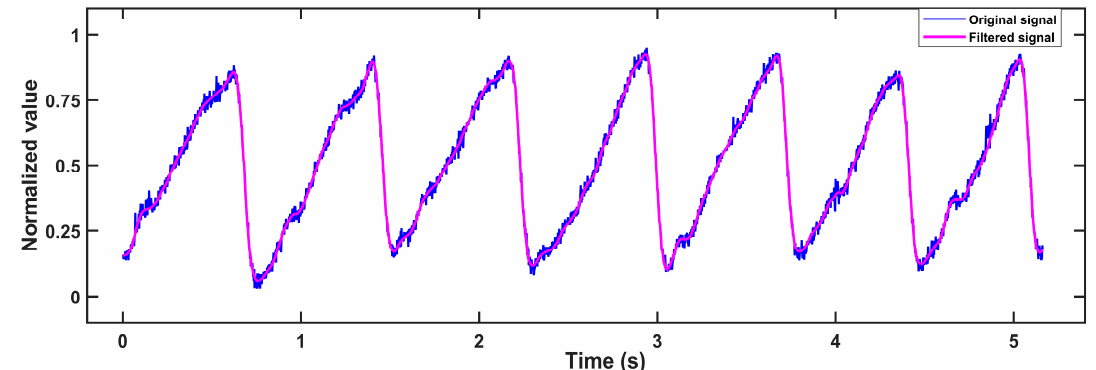
Figure 8. Original signal (blue) and fi ltered signal (purple).